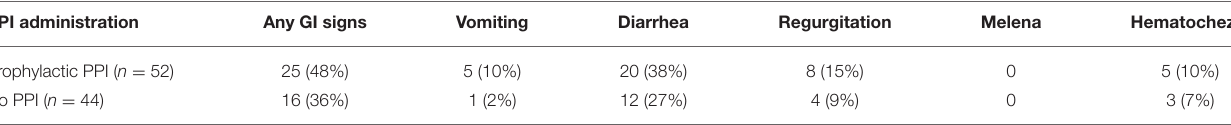
TABLE 4 | Frequency of GI signs in 96 of 116 dogs undergoing surgery for TL-IVDE with or without prophylactic PPI administration. PPI administration Any GI signs Vomiting Diarrhea Regurgitation Melena Hematochezia Prophylactic PPI ( n =